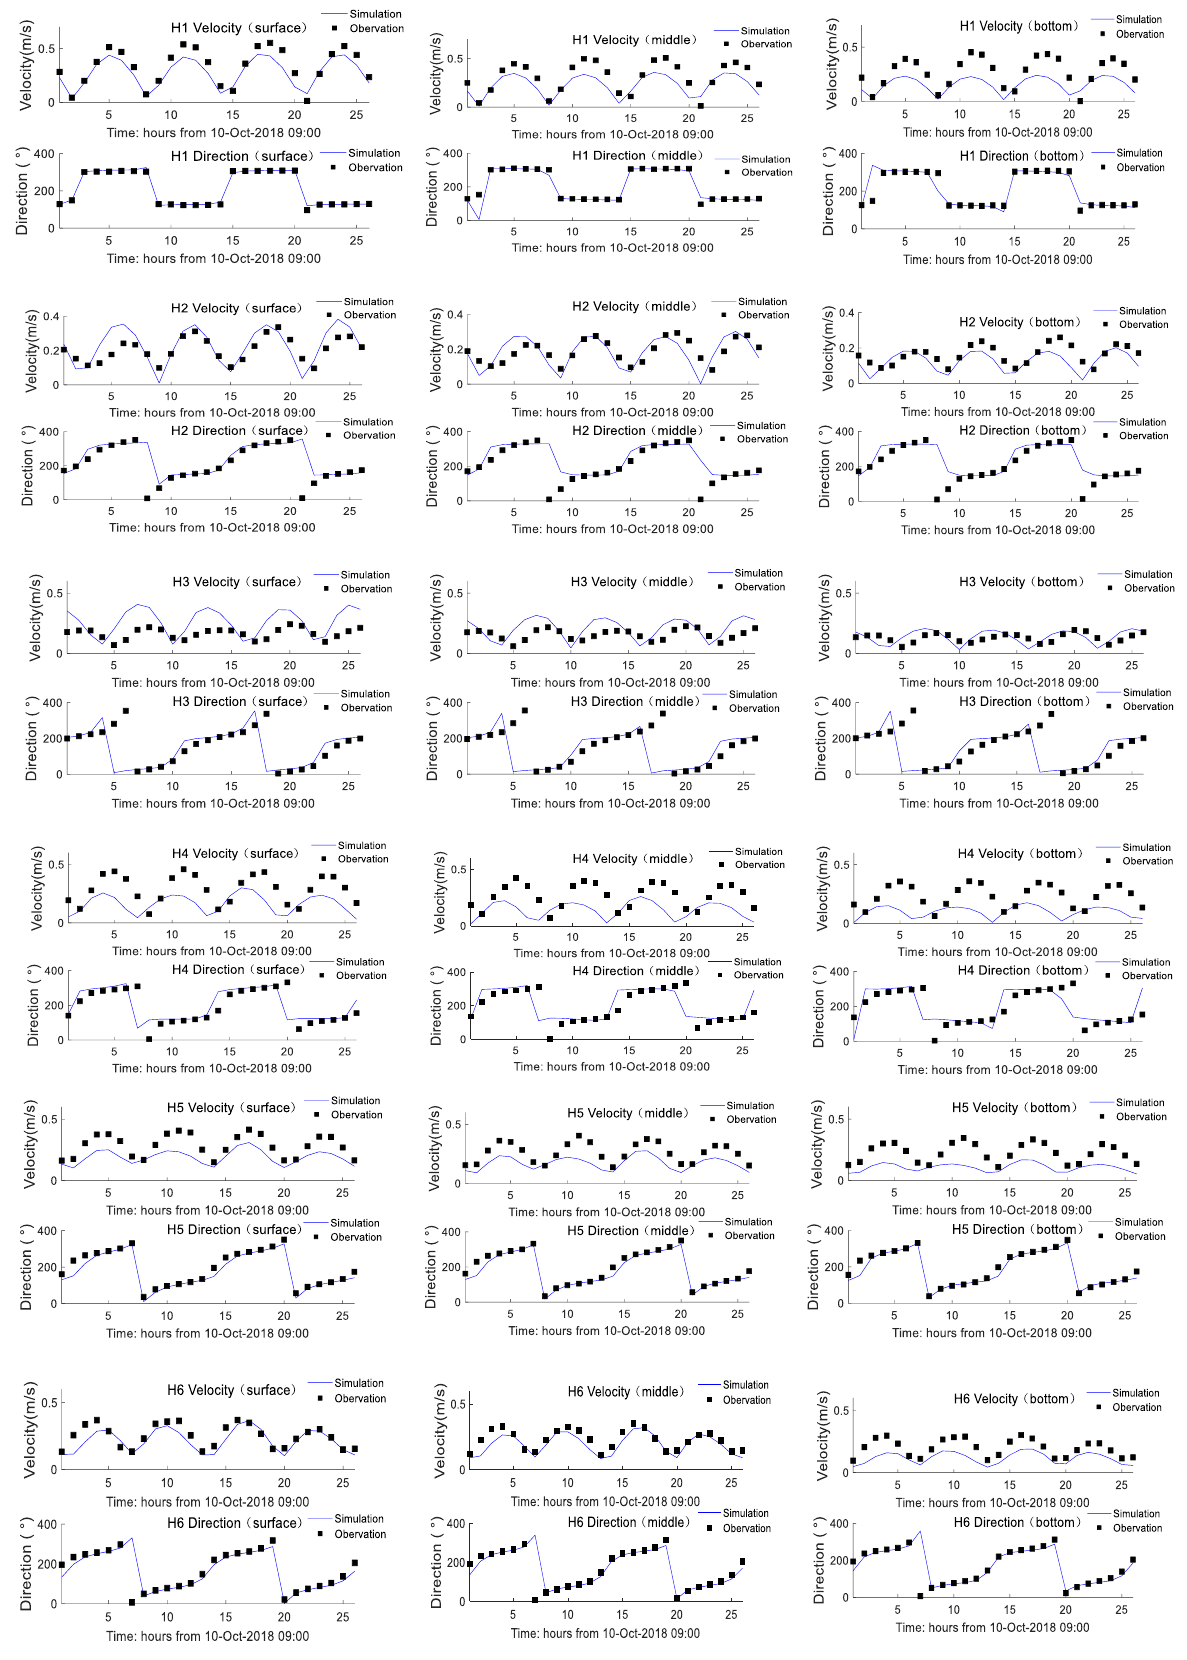
Figure 7. Verification of tidal current.